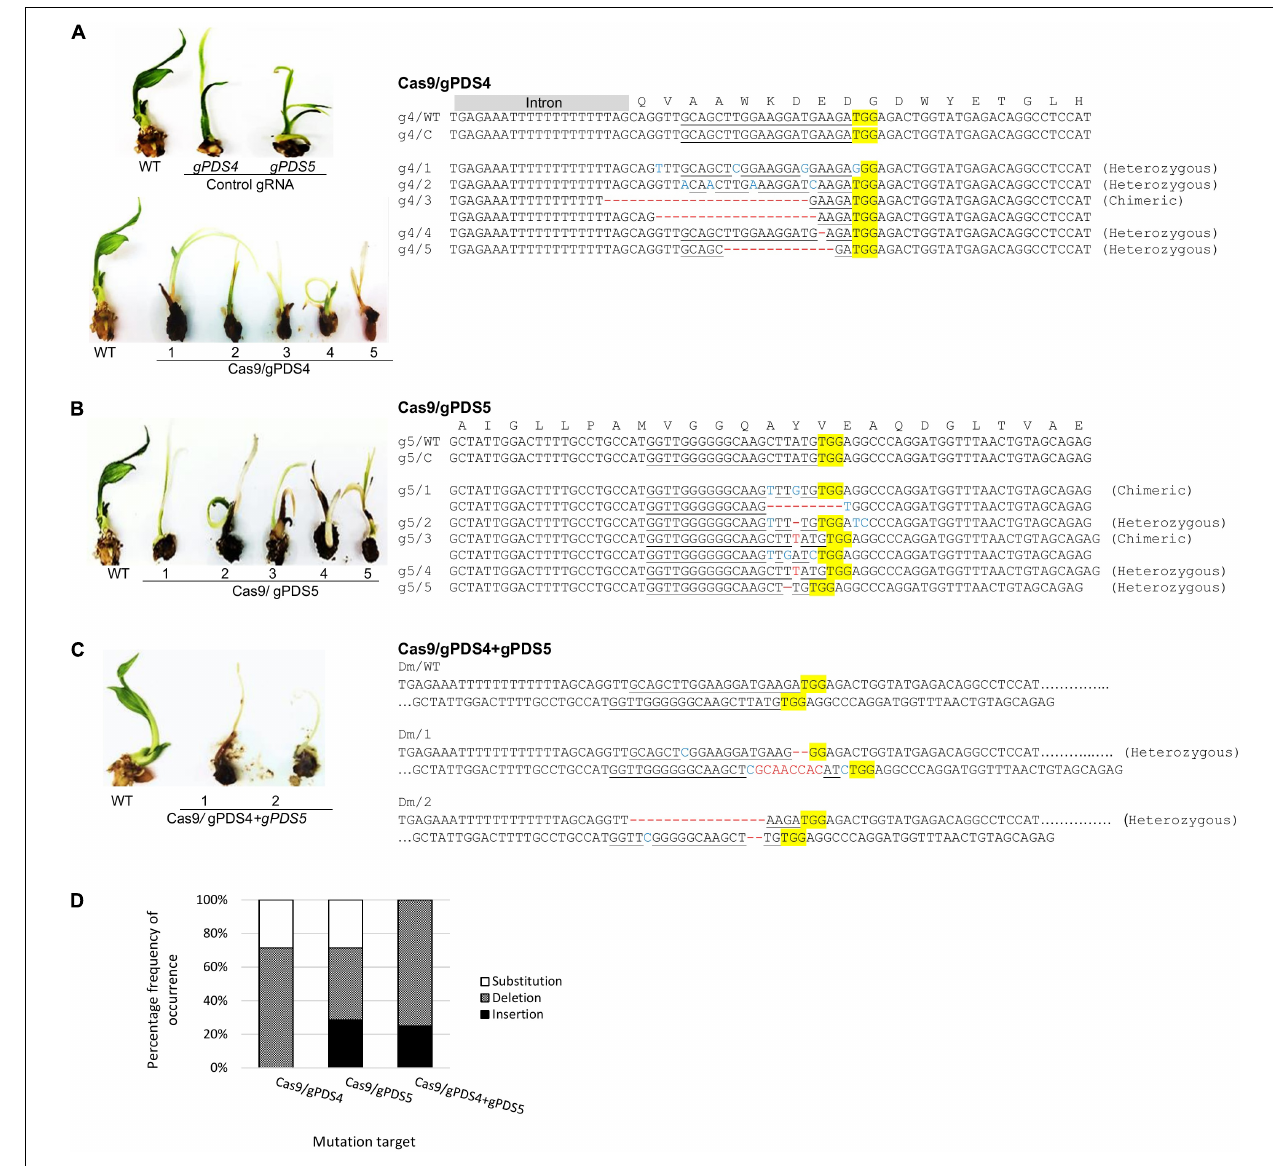
FIGURE 3 | Mutation events of targeted CRISPR/Cas9 mutagenesis of EgPDS gene in in vitro transgenic oil palm. Mutation events detected in the transgenic oil palms exhibiting the chimeric albino phenotypes using sequencing-based detection at the target sites of (A) gPDS4, (B) gPDS5, and (C) both gPDS4 and gPDS5 in the EgPDS gene and (D) the percentage frequency of occurrence for each type of mutation event. Protospacer adjacent motif sequence (PAM) is highlighted in yellow, InDels sequences of the target site are shown in red, and nucleotide substitution are marked in blue. g4, gPDS4; WT, wild-type; C, control; g5, gPDS5; Dm, double mutant; 1–5, plantlet